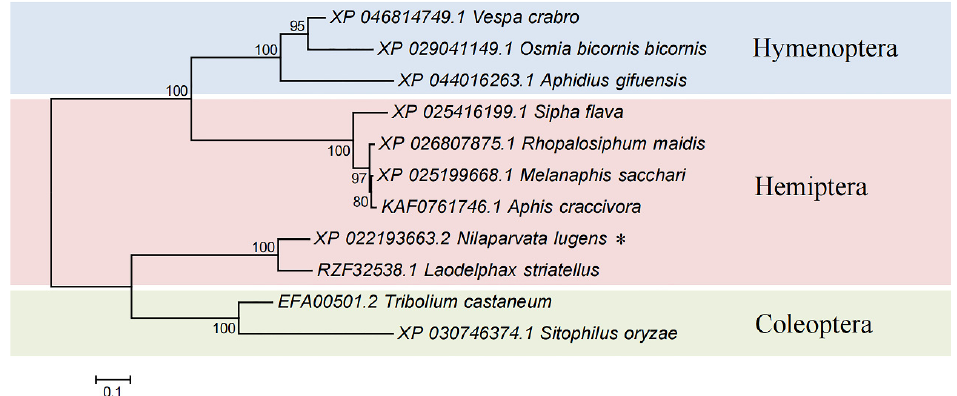
Figure 2. Phylogenic analysis of Cpr21L. The tree was constructed using MEGA 7.0 software (neighbor ‐ joining method with n = 1000 bootstrap replications). Bootstrap values above 70% are shown on each node. Cpr21L (XP _022193663.2) is marked with an asterisk (*).